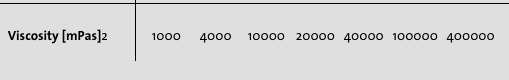
Table 1: The Newtonian vis- cosity in mPas that produces a 100% torque scale reading for N = 10 rpm for Brookfield 1- 7 spindles respectively. (N.B. the current nomencla- ture of this series of spindles is RV/HA/HB-m, where m is